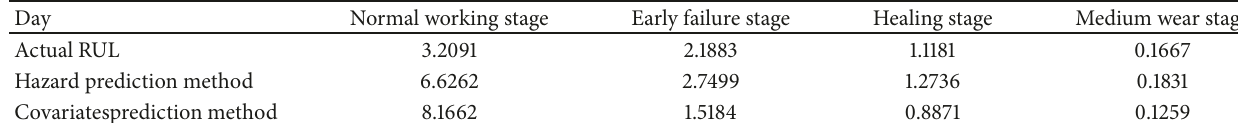
Table 2: RUL prediction.